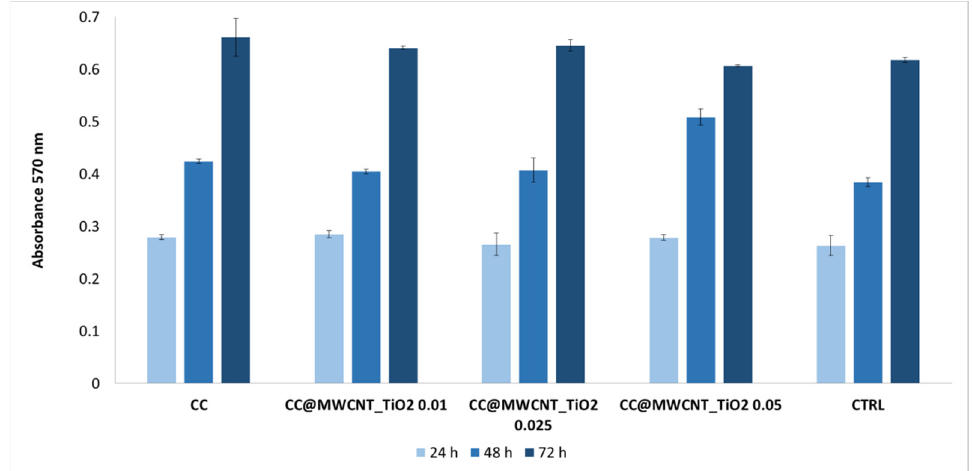
Figure 12. The viability of HDFn cells in the presence of films by MTT assay; the results are presented as the mean ± S.D. of three replicates.